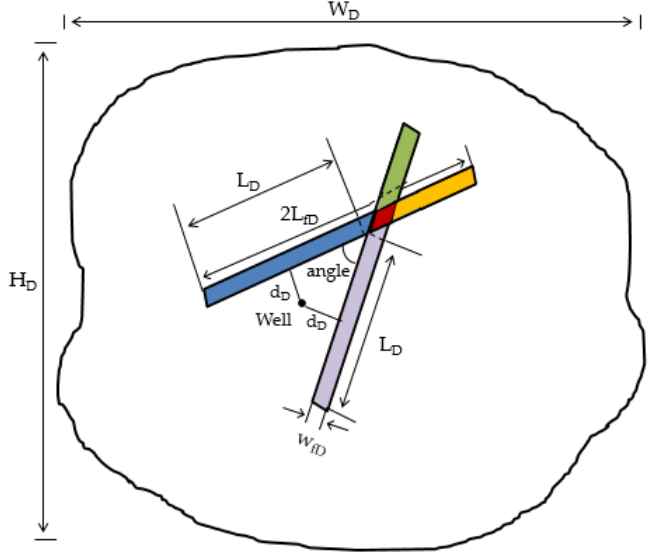
Figure 14. Reservoir with isolated, crossing, natural fractures; the variable values of all terms.